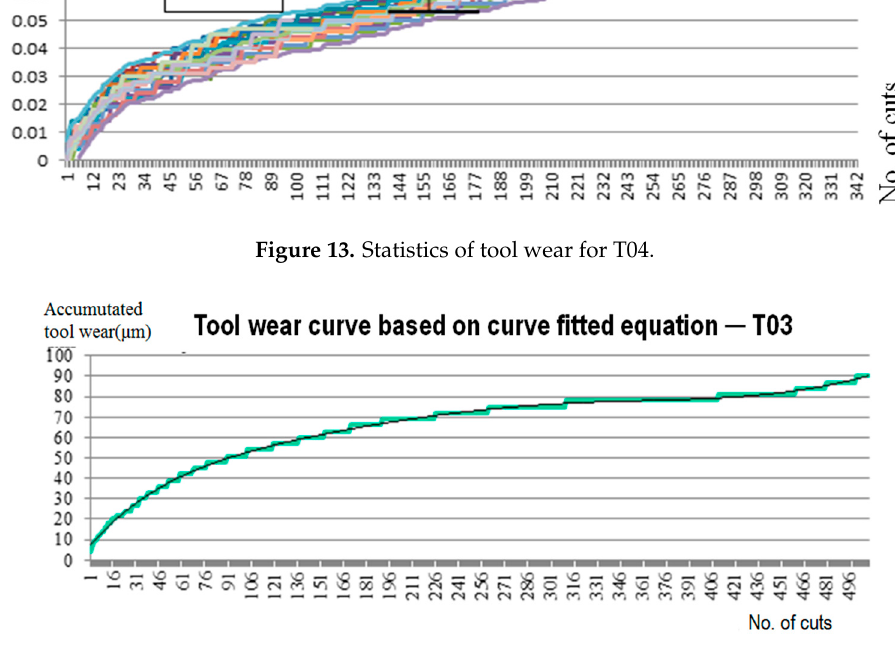
Figure 14. Tool wear curve for T03.